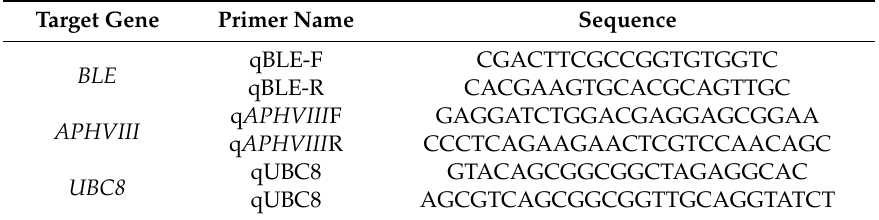
Table A1. Oligonucleotides used in this work for quantitative RT-PCR